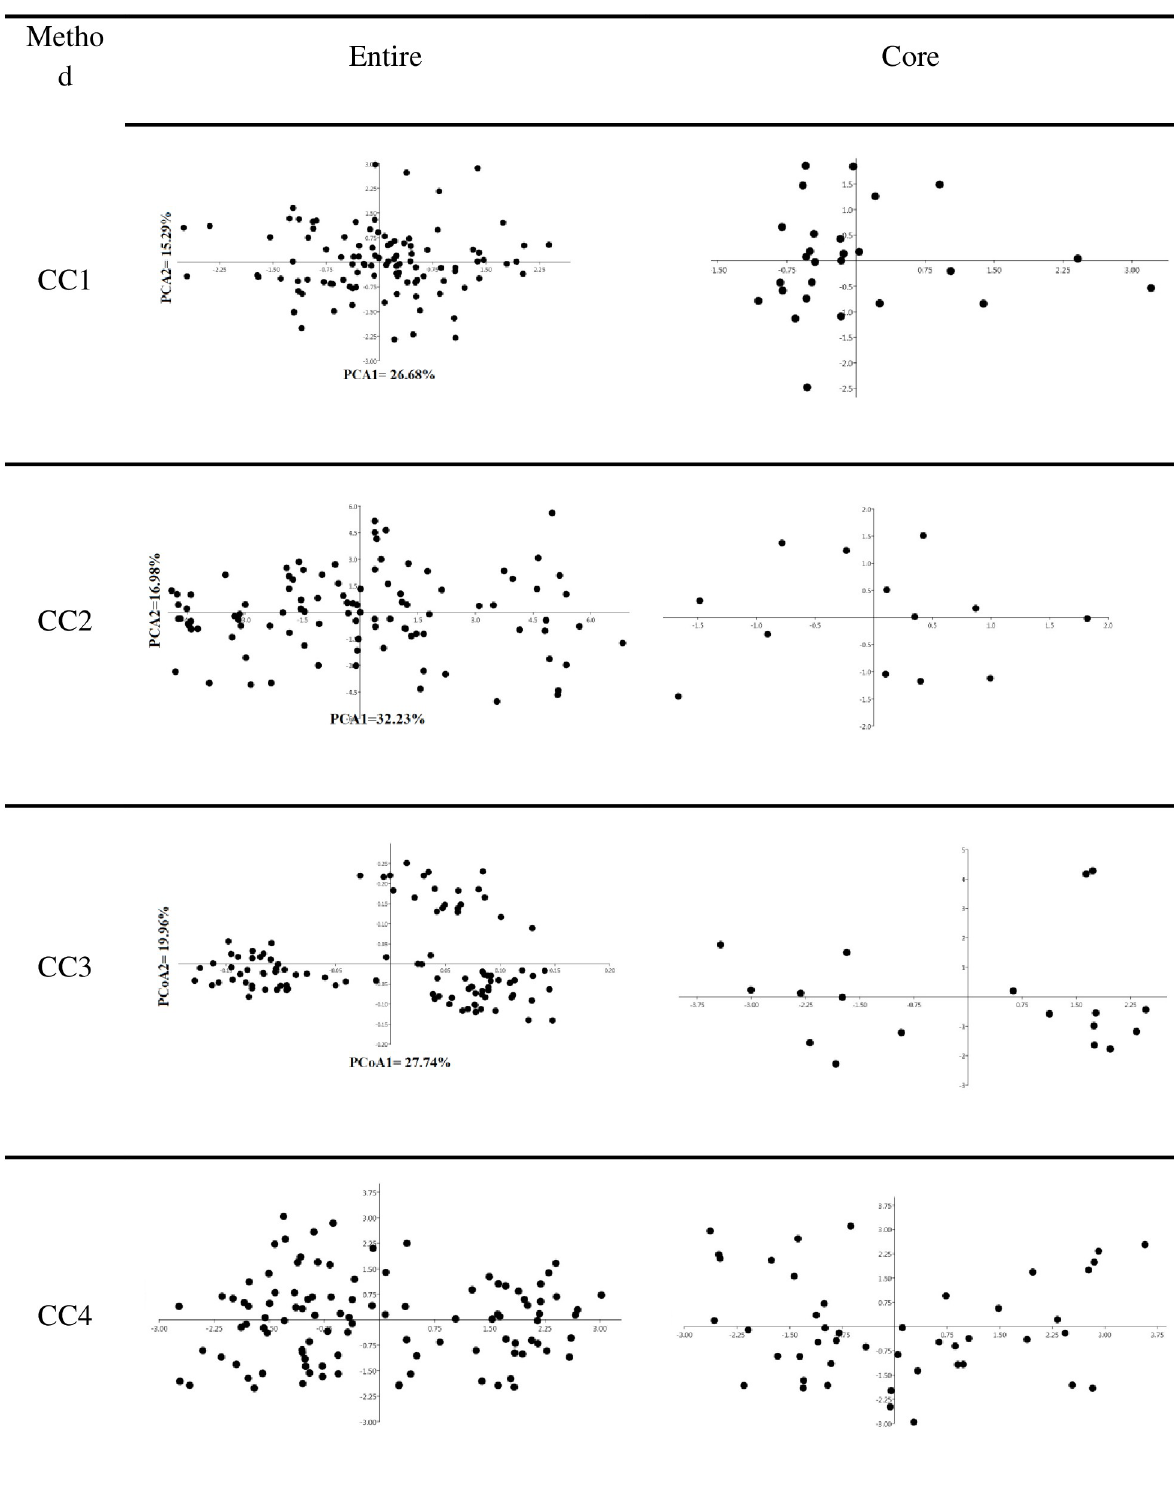
Fig 5. PCA graphs depicting spread of members of the composite and the three independent core collections.